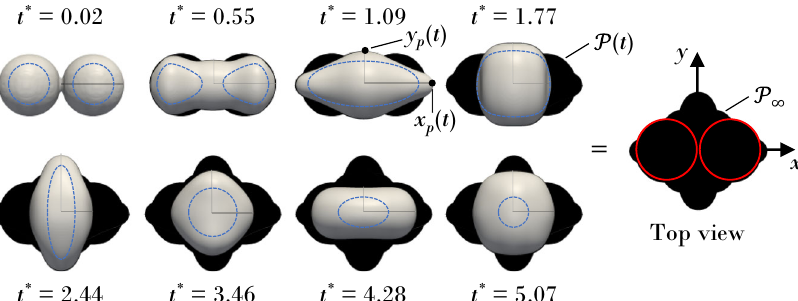
Fig. 4 Extensional and swept areas during coalescence showing the evolution of the x -axis x p ( t ) and y -axis y p ( t ) projected extensions. The contact-line position (dashed blue line) is superimposed on the top view. Instantaneous cumulative projected swept areas P ð t Þ are indicated by the black silhouettes, with the fi nal cumulative projected swept area P 1 shown on the rightmost image. The circles on P 1 (red solid) represent the initial projected drop areas.